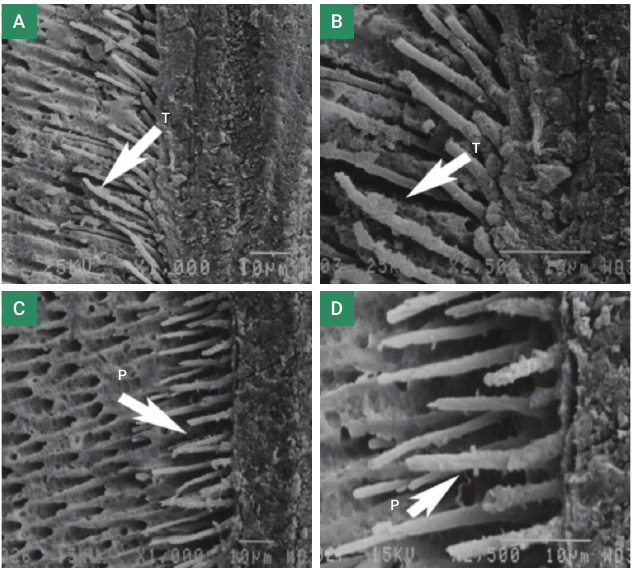
Figure 2. Selected SEM micrographs of resin-dentin interface in the control group; (A) Single Bond at x1000 magnification; (B) Single Bond at x2500 magnification; (C) OptiBond at x1000 magnification; (D) OptiBond at x2500 magnification. Conical resin tags with a rough surface (T) and a few accessory canals filled with resin (P) are also seen.